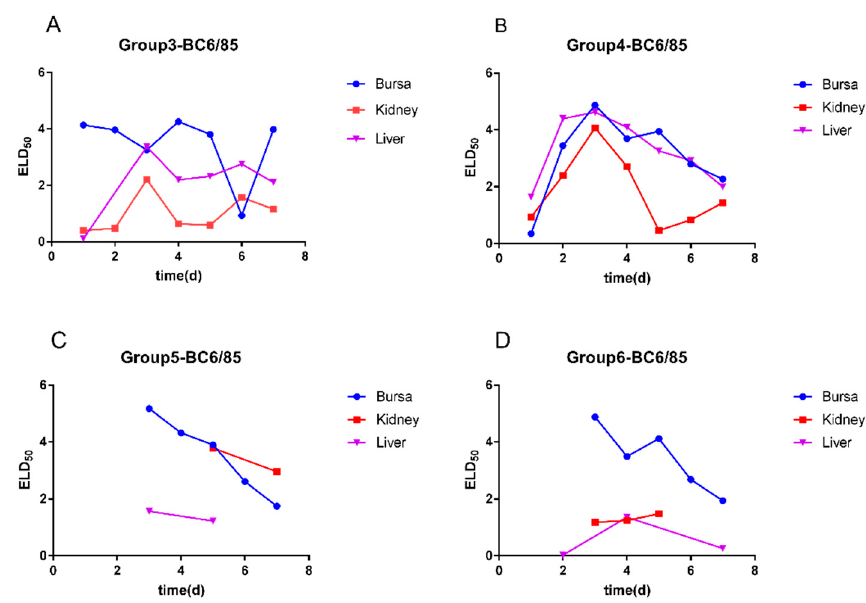
Figure 3. Viral loads of BC6/85 in the bursa of Fabricius, liver, and kidney of SPF chickens with sequential infection of B87 and BC6/85. ( A ) BC6/85 in Group 3, ( B ) BC6/85 in Group 4, ( C ) BC6/85 in Group 5, and ( D ) BC6/85 in Group